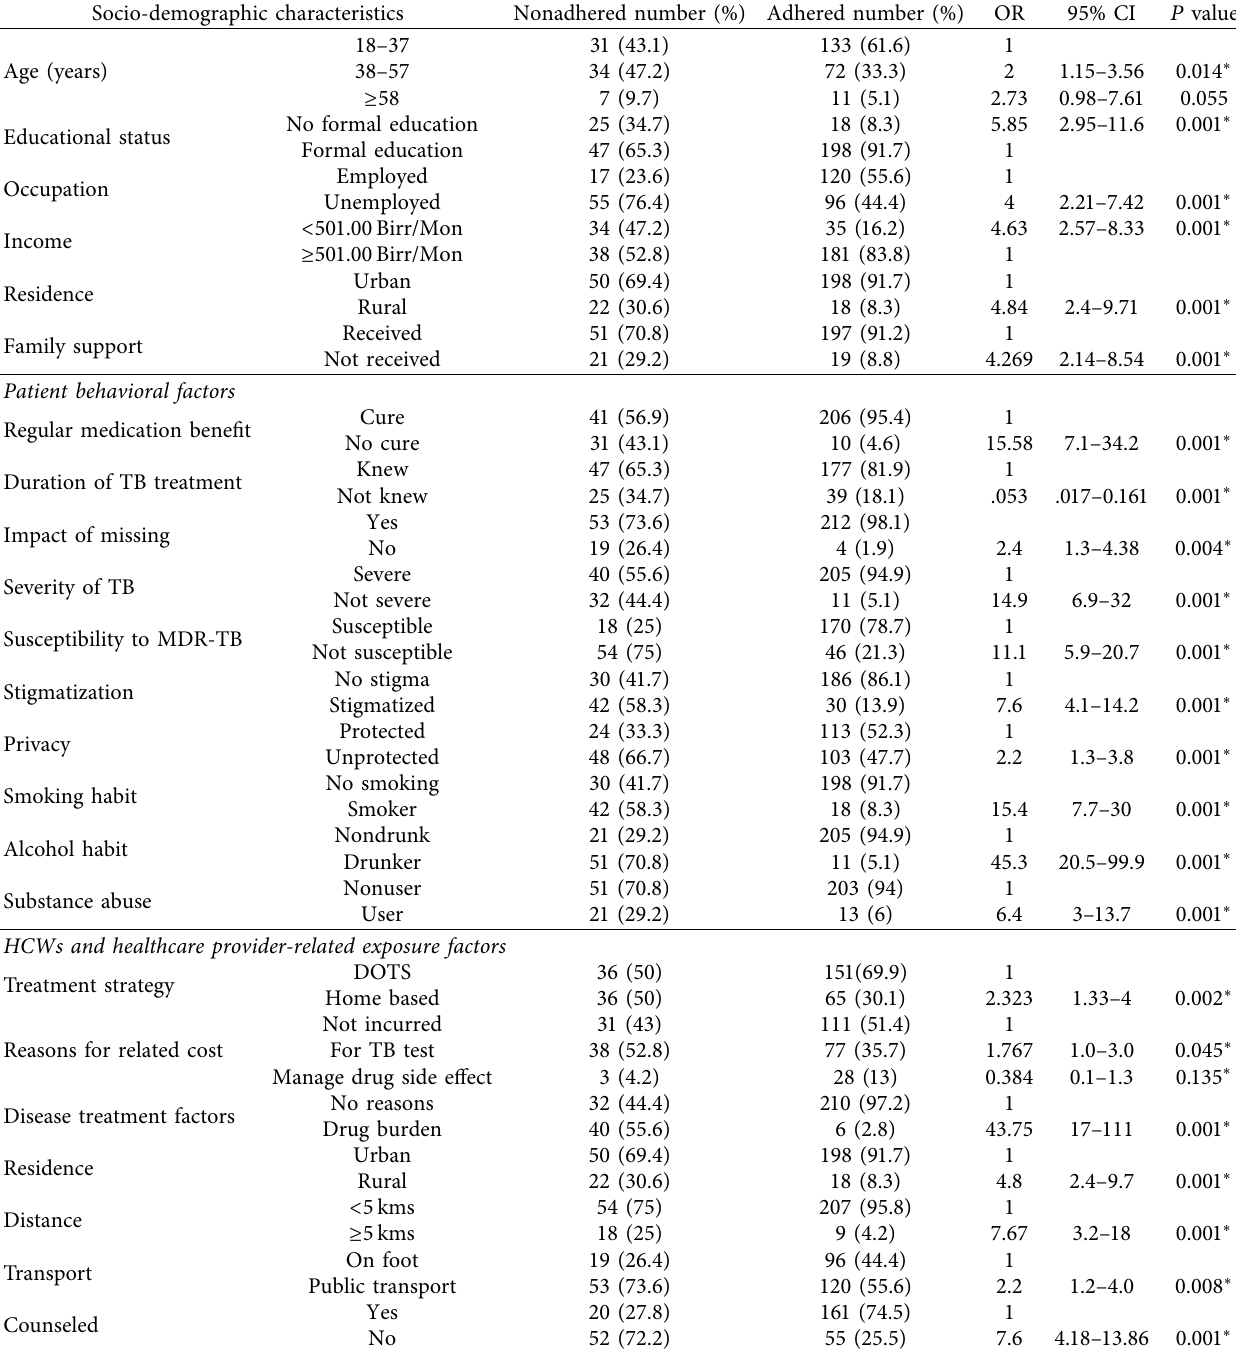
Table 5: Bivariate analysis of socio-demographics, patient’s behavior, and HCWs and healthcare provider-related factors are associated with nonadherence to anti-TB medications in Gambella. Socio-demographic